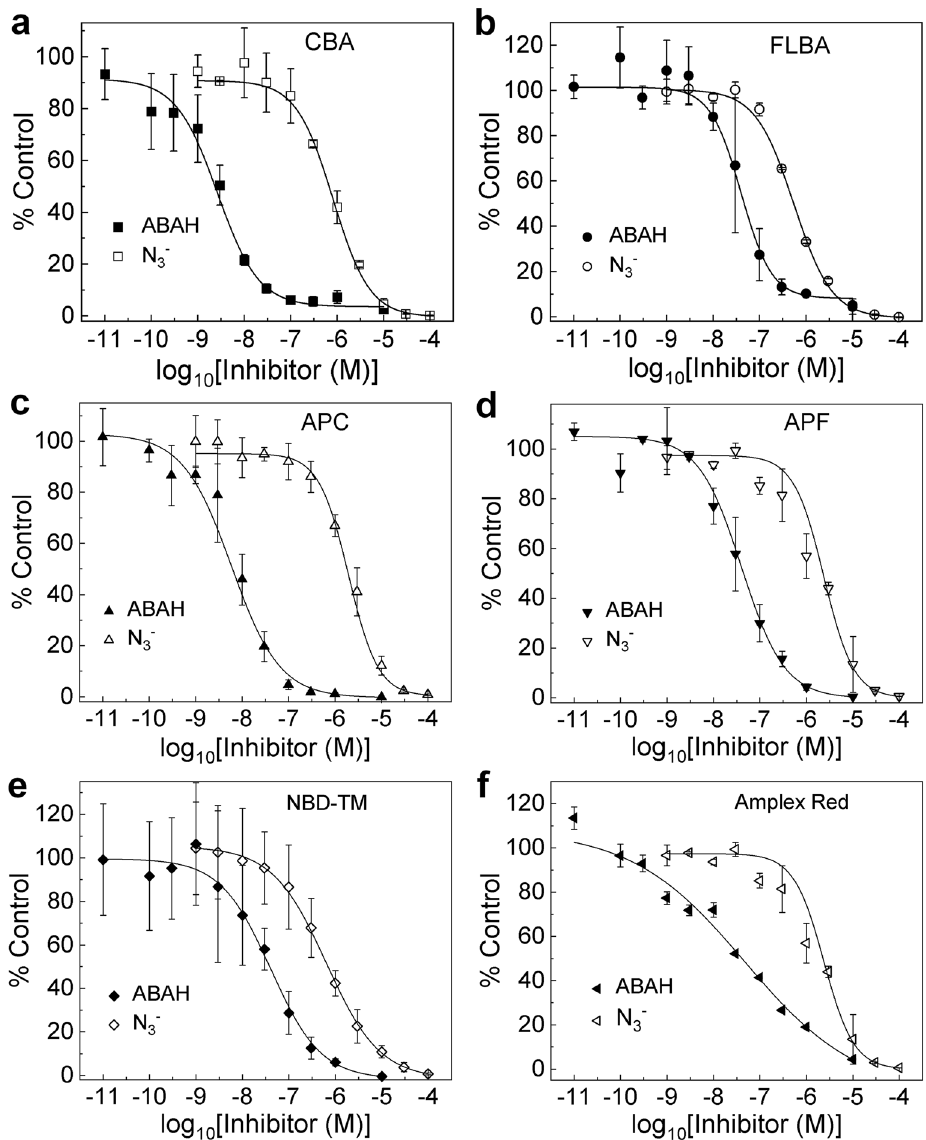
Figure 5. ( a ) Dose–response curve for ABAH and azide anion determined by CBA assay. ( b – e ) same as ( a ) but instead of CBA the FLBA, APC, APF, and NBD-TM probes have been used, respectively. Mixtures contained MPO (1.2 nM), H 2 O 2 (10 µM), NaCl (0.1 M), phosphate buffer (50 mM, pH 7.4), and the appropriate probe (20 µM). ( f ) Dose–response curves for azide anion and ABAH determined by peroxidative activity assay. Mixture contained Amplex Red (20 µM), MPO (1.2 nM), H 2 O 2 (10 µM), phosphate buffer (50 mM, pH 7.4), and azide anion or ABAH, but no NaCl. In the calculations the initial rates of probes oxidation were used. (Data are